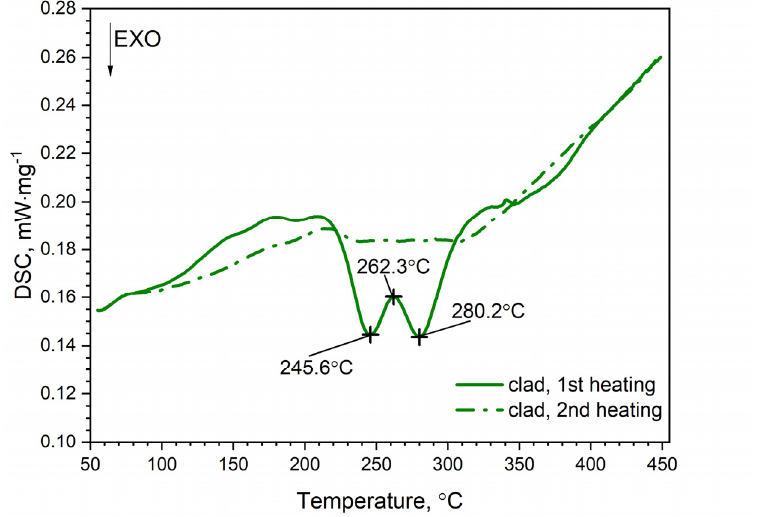
Figure 8. DSC thermograms of clad AW-2024-T3.